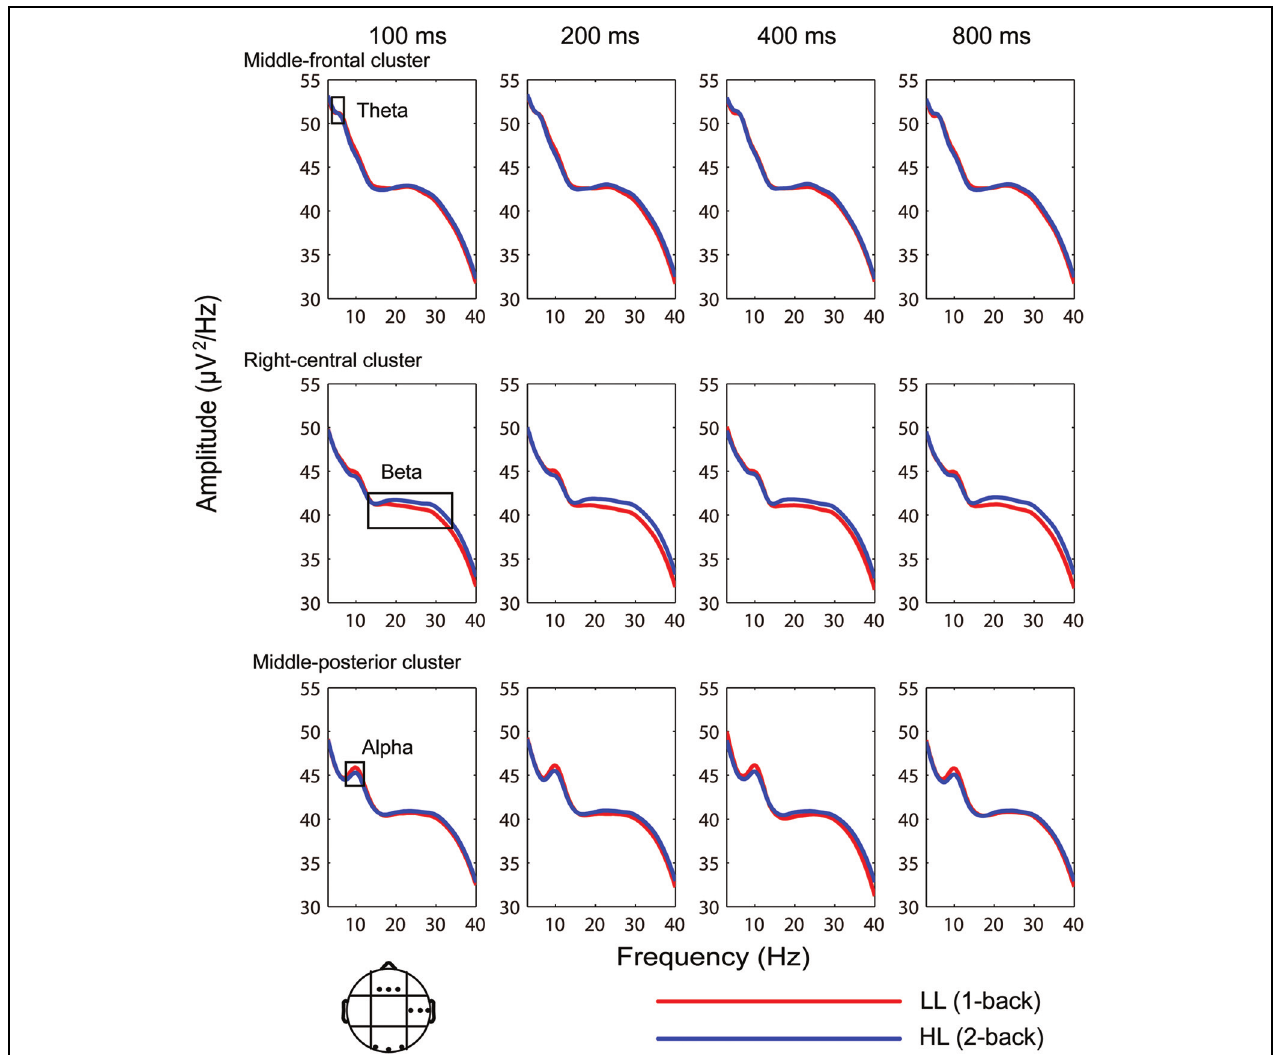
FIGURE 5 | Average EEG spectral power ( − 400 to 1400 ms) for the 100-, 200-, 400-, and 800-ms durations under the low (LL) and high (HL) memory load conditions in the middle-frontal, right-central, and middle-posterior clusters.